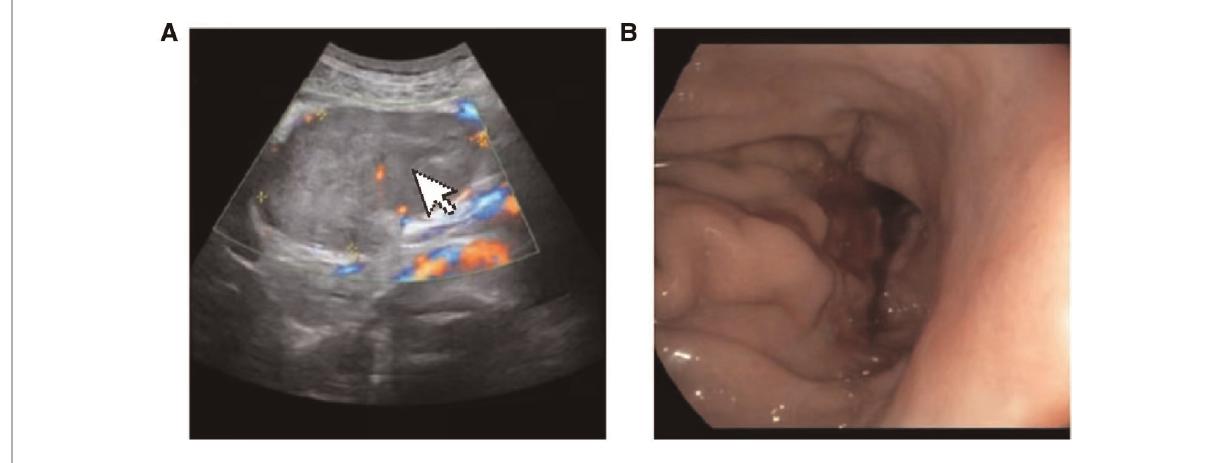
FIGURE 1 ( A ) Doppler ultrasound:upper abdominal solid mass. ( B ) Gastroscopy: chronic atrophic gastritis C1: gastric antrum mass (to be